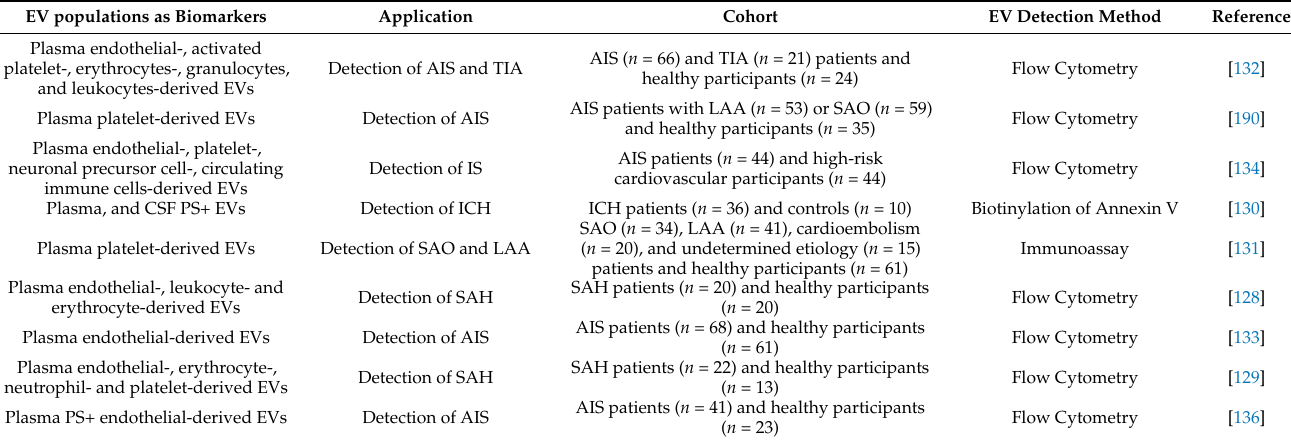
Table 1. EV population as biomarker candidates in